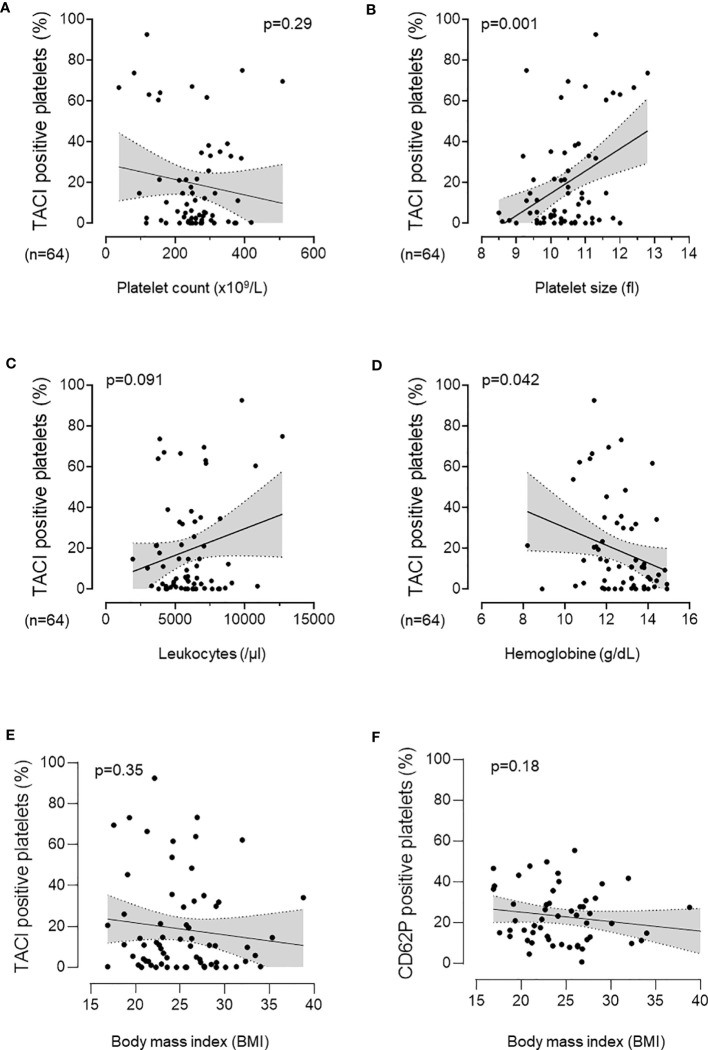
Association of pTACI with hematological and clinical parameters. Correlation of pTACI expression and platelet count (p = 0.29) (A), platelet size (p = 0.001) (B), leukocyte count (p = 0.091) (C) and hemoglobin concentration (p = 0.042) (D). Association of pTACI level (p = 0.35) (E) and platelet activation (CD62P expression) (F) (p = 0.18) with Body mass index (BMI). Line indicates linear regression, gray area 95%CI interval (n = 64 breast cancer patients).